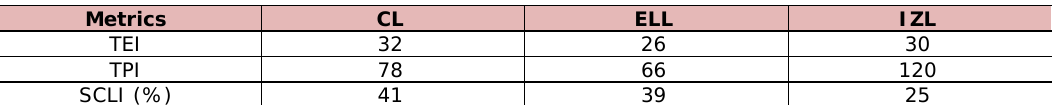
Table 3. “Concept comparison using SCLI”. Sources: